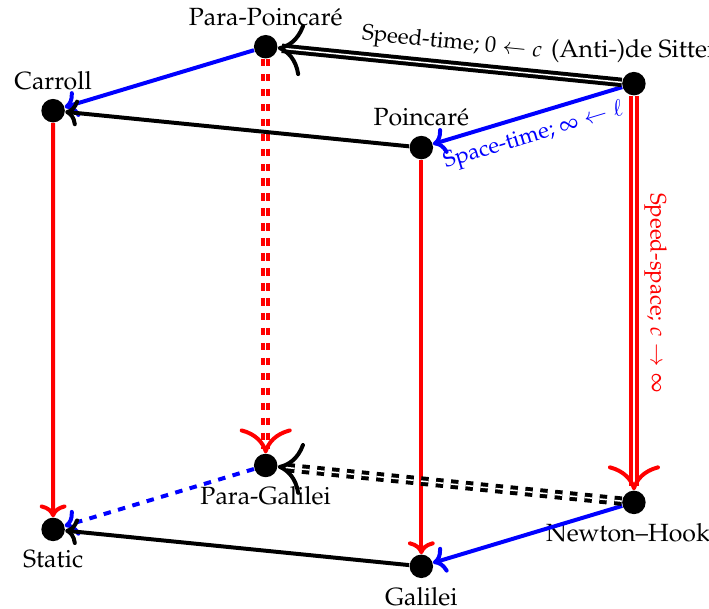
Figure 1. This cube summarizes the kinematical Lie algebras [183]. Each dot represents a kinematical Lie algebra, given explicitly in Appendix A, and each arrow represents an ˙Inönü–Wigner